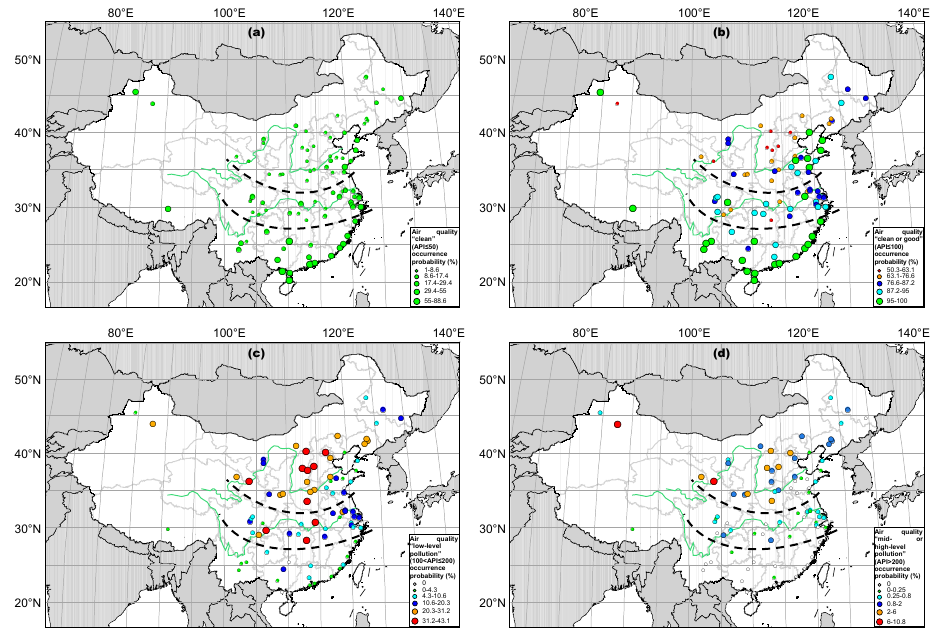
Fig. 3. Spatial distribution of the occurrence probability of the days with air quality classification as (a) “clean (API ≤ 50)”, (b) “clean or good (API ≤ 100)”, (c) “low-level pollution (100 < API ≤ 200)” and (d) “mid- or high-level pollution (API > 200)” for the eighty-six